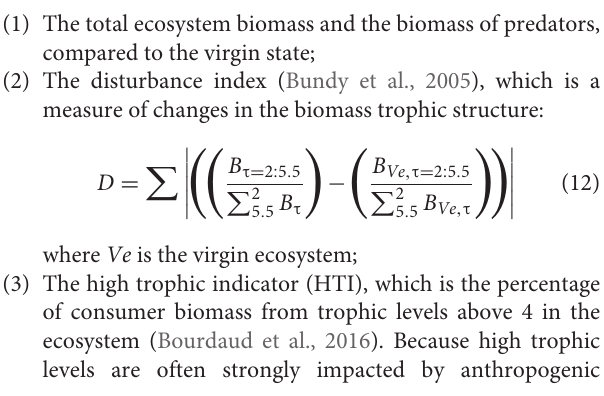
( Supplementary Figure 2 ): the lower the efficiency the lower